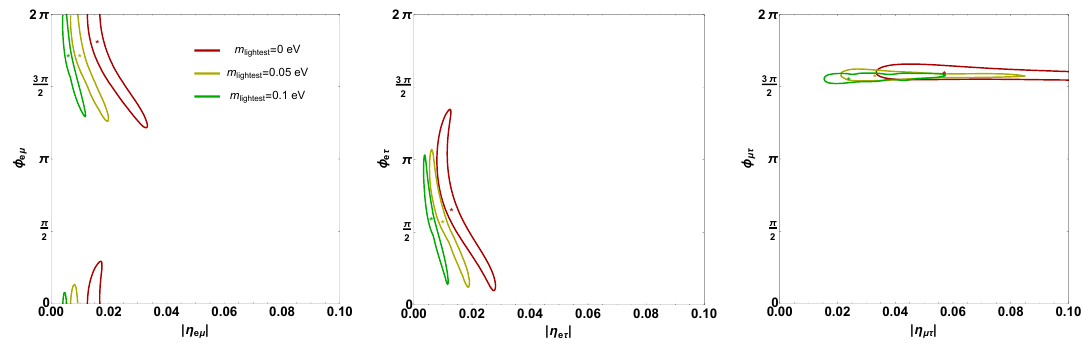
Figure 5 . 68% contours in DUNE in the ( | η ij | − φ ij ) -planes when data are generated using scalar NSI best fits in the IO case considering one NSI parameter at a time. The red curve is obtained with m = 0 , the blue one with m = 0 . 05 eV and the green one with m lightest lightest